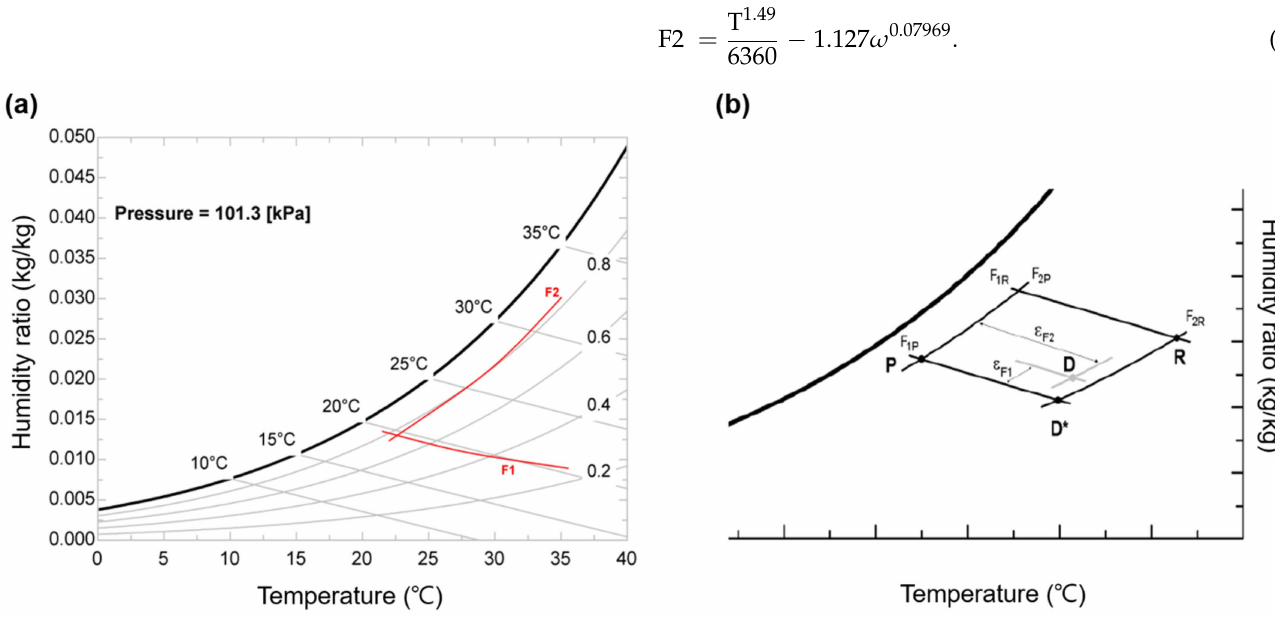
Figure 5. Psychrometric process of the desiccant rotor: ( a ) isopotential lines of F1 and F2 with wave effects [23] and ( b ) dehumidification and regeneration paths obtained from F1 and F2